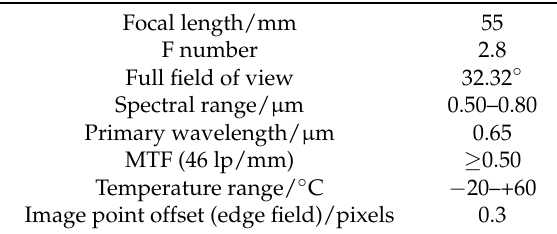
Table 1. Indexes of the Luojia 1-01 camera.